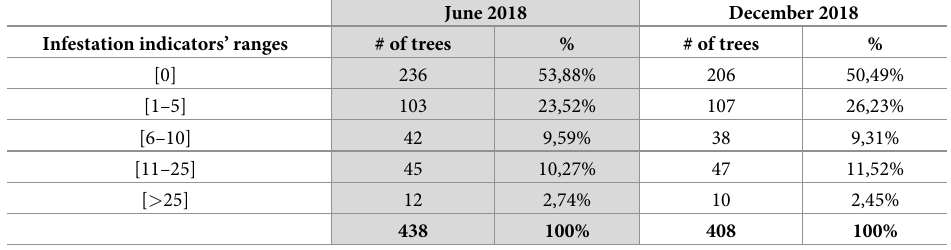
Table 1. Trees sorted according their sum number of infestation indicators (EH+BI+GS) in June and in December 2018.